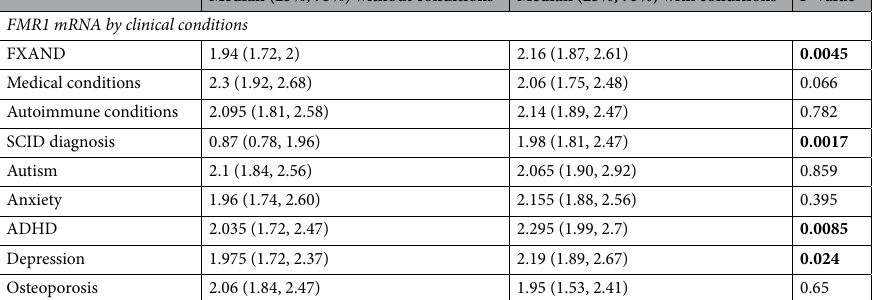
Median (25%, 75%) without conditions Median (25%, 75%) with conditions P -value FMR1 mRNA by clinical